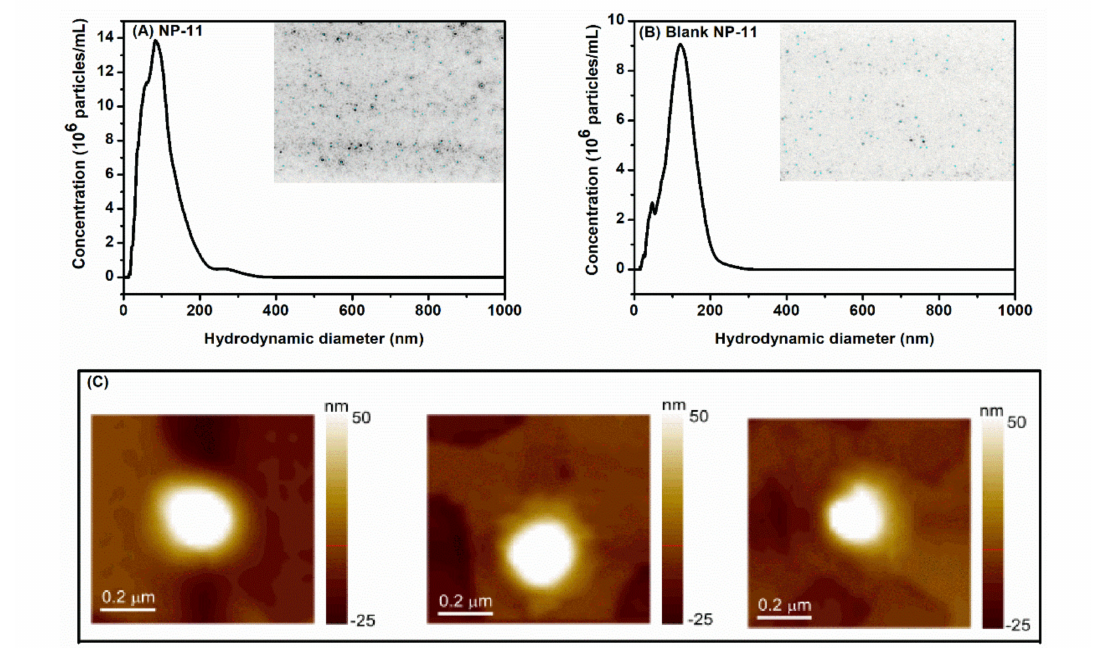
Figure 4. Size distribution for ( A ) NP-11 and ( B ) blank NP-11 from NTA measurements. Inserts show NTA video frames for both samples. ( C ) AFM images obtained for